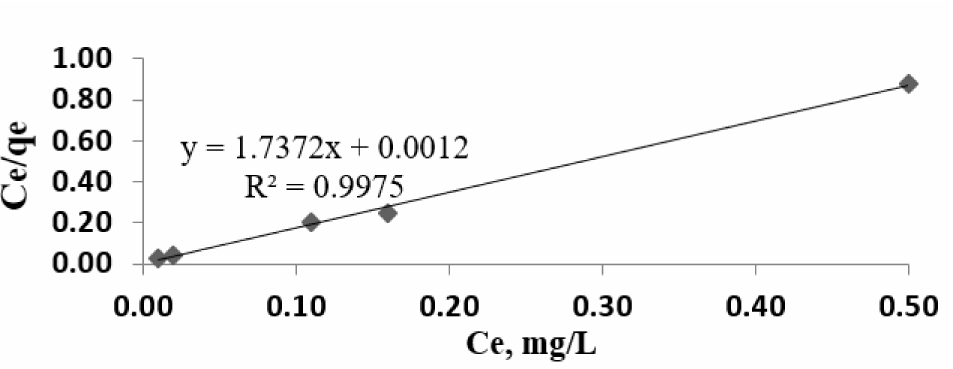
Figure 7. Experimental isotherm for different concentrations of lead ions (0.70; 1.00; 1.20; 1.45; 1.64 mg/L).